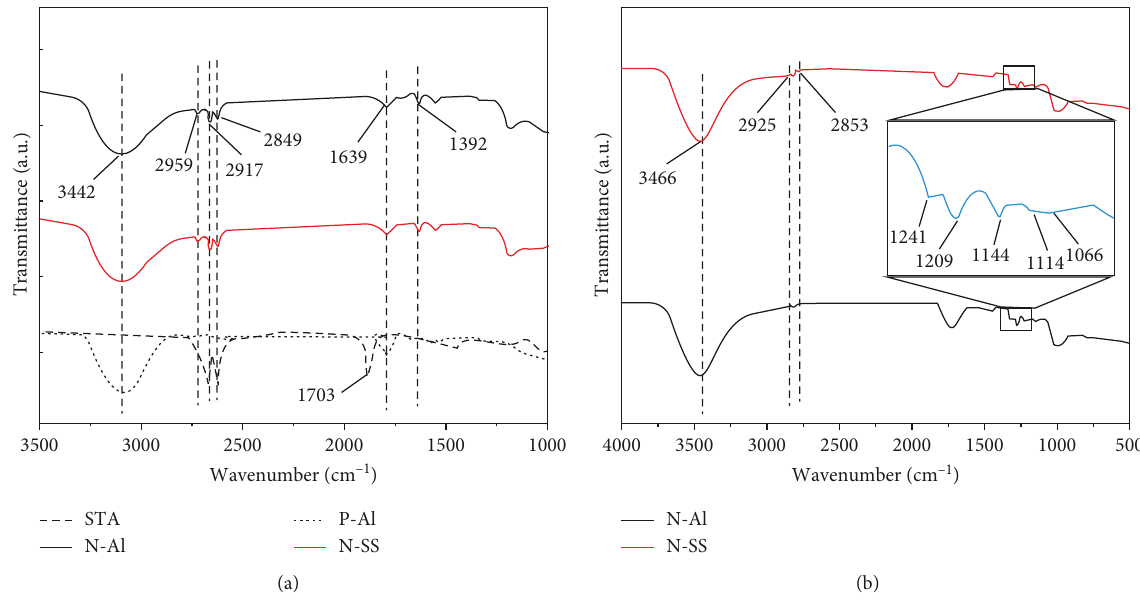
Figure 5: FTIR patterns of N-SS and N-Al prepared after EPD and modified by (a) STA and (b)